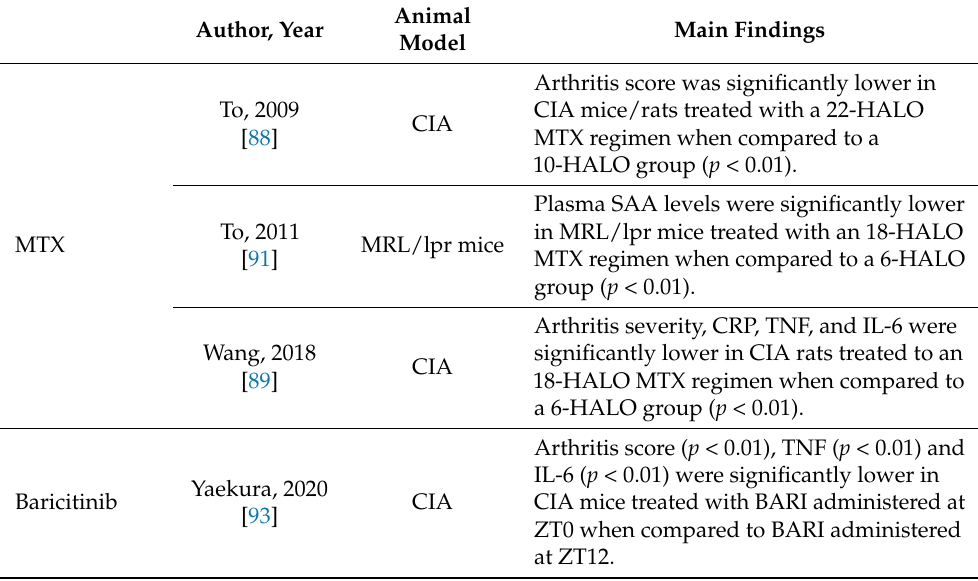
Table 1. Preclinical evidence for chronotherapy according to the results obtained in animal models of